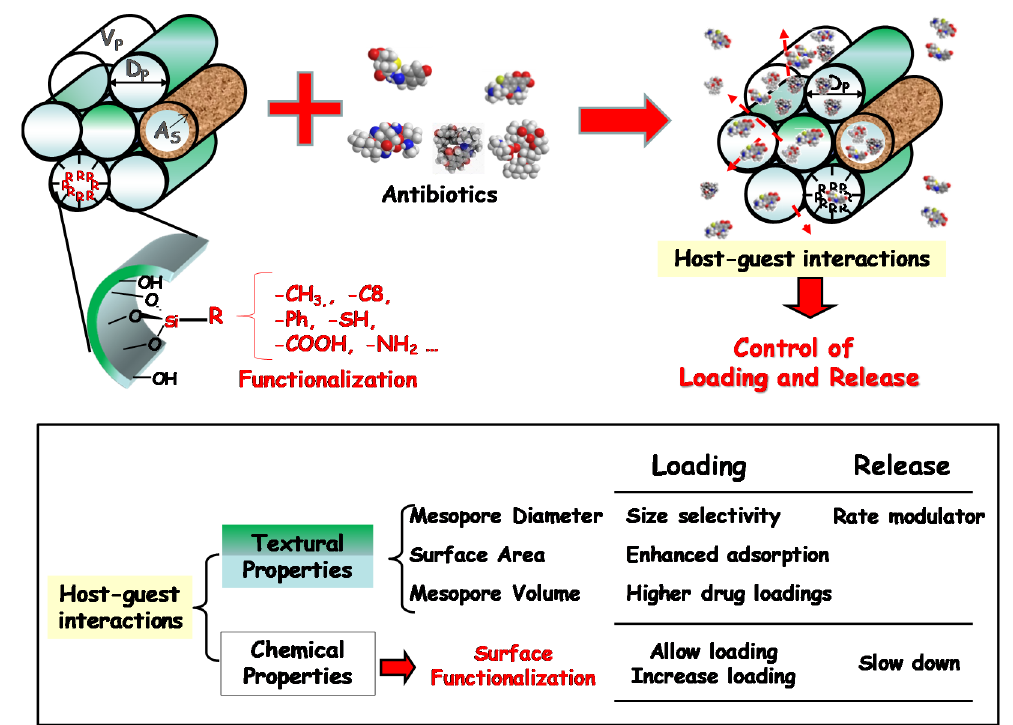
Figure 2. Influence of the textural and chemical properties of the silica-based mesoporous matrices in their performance as drug delivery systems.